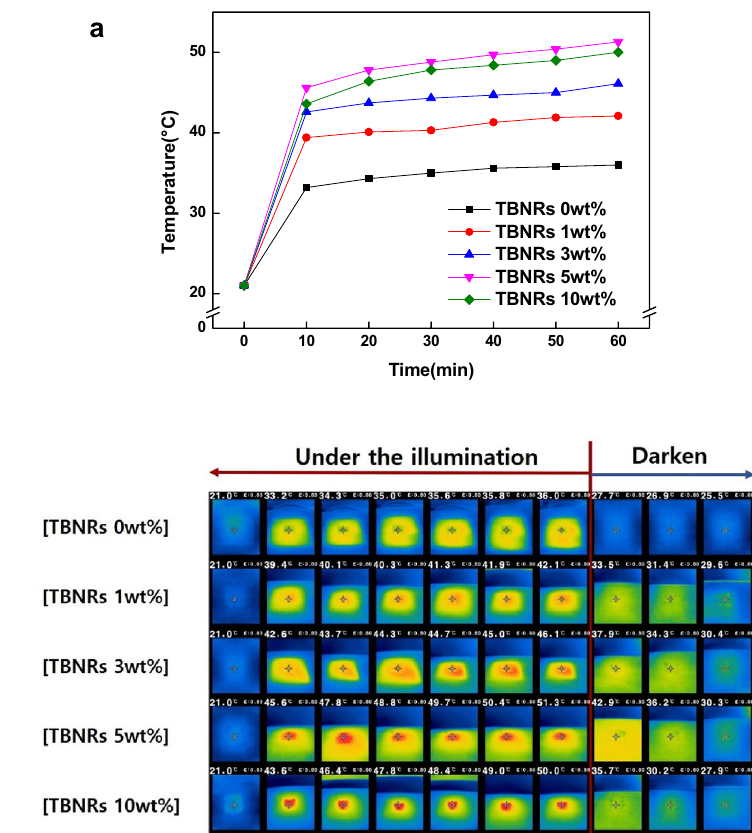
Fig. 5 Graph of temperature change of PET samples with time ( a ) and NIR images ( b ) under white light irradiation for 1 h and after turning off the light for the following 15